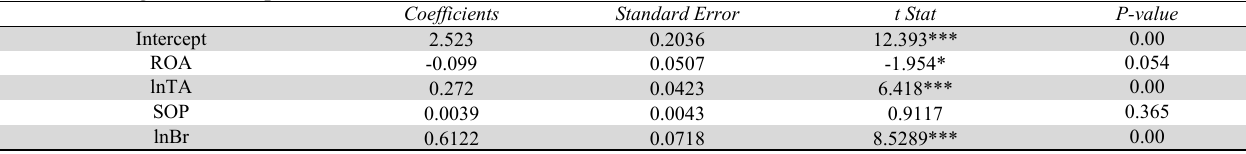
Pearson Correlation Matrix Staff SOP Branch Staff